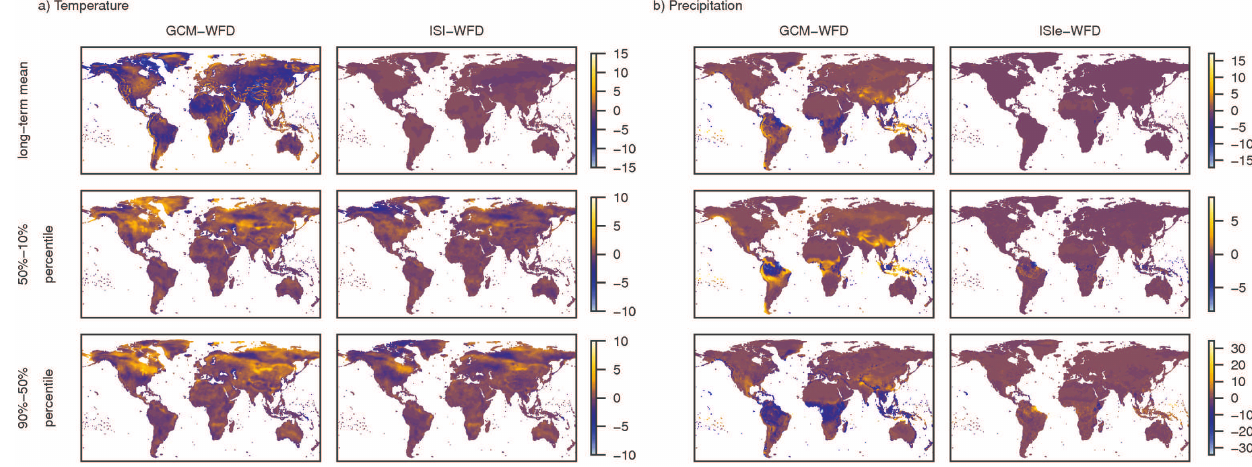
Fig. 8. The anomalies (simulation – observation) of statistical properties in raw (GCM) and bias-corrected (ISI and ISIe) model data are shown. The trend-preserving ISI-MIP methodology was applied to the period 1960 to 1999 for bias correction based on a 40yr reference period (1960 to 1999). The illustration is analogous to Fig. 7. Colours refer to (a) temperature values in K and (b) precipitation values in mmday − 1